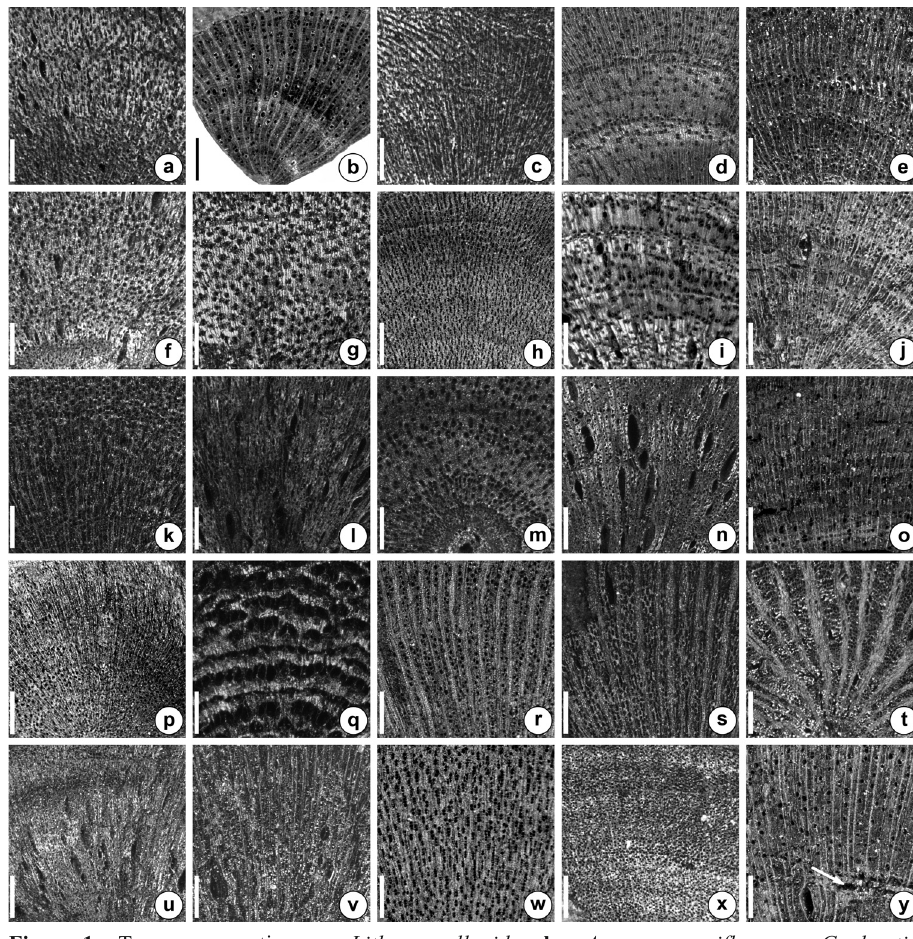
Figure 1 - Transverse section: a – Lithrea molleoides . b – Annona crassiflora . c –